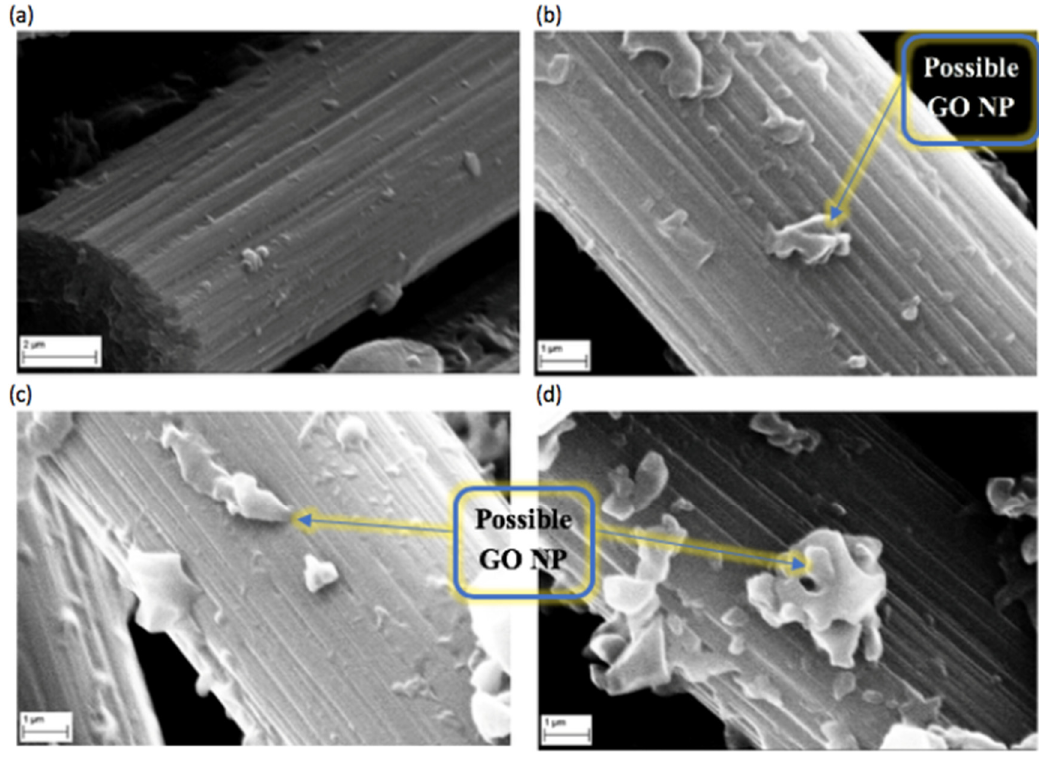
Figure 11. SEM images of deposited particles collected in sampling tray from drilling on ( a ) EP/CF sample, ( b ) EP/CF/GO 0.05 wt.% sample, ( c ) EP/CF/GO 0.1 wt.% sample and ( d ) EP/CF/GO 0.5 wt.% sample.